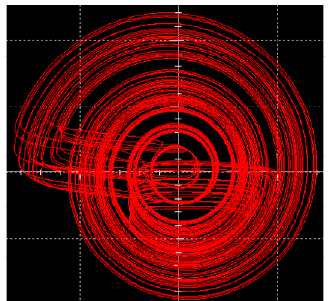
Figure 17. The typical chaotic attractor of the memristive chaotic system by Multisim. Correspondingly the physical circuit of the memristor-based chaotic system is given to further